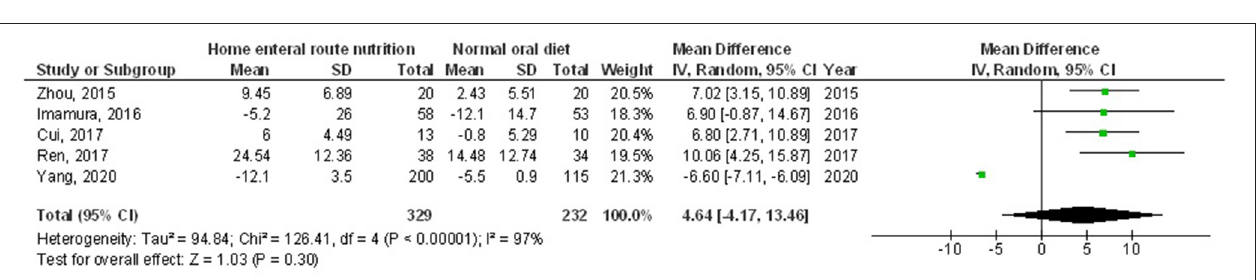
FIGURE 6 | A forest plot of the hemoglobin in subjects with upper gastrointestinal cancer resection with the home enteral nutritional support compared to the normal oral diet.